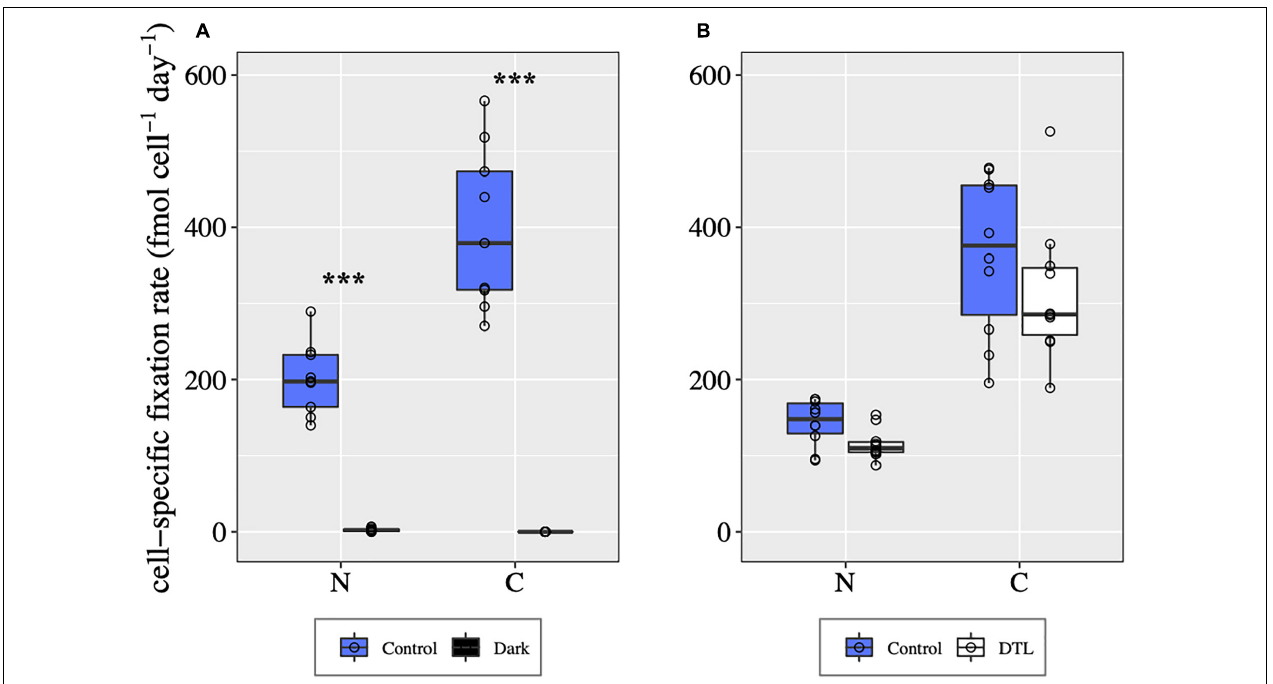
FIGURE 5 | UCYN-A symbiosis cell-specific C and N 2 fixation rates in different light-dark conditions during day 1 (A) and day 2 (B) , determined for individual UCYN-A2/haptophyte symbiotic assemblages. For each condition, the values shown for C fixation and for N 2 fixation were obtained from the same n cells, with n = 10 for each condition except for the control from day 1 for which n = 9. ***indicates significant differences between conditions ( p < 0.0001) as determined by a Mann–Whitney